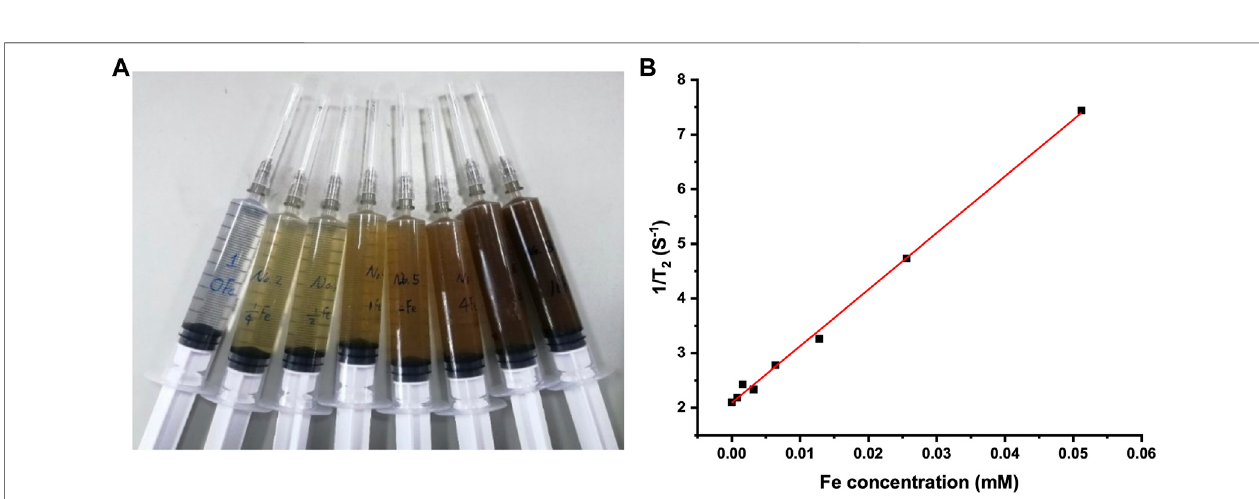
FIGURE 2 | (A) Photo of the Fe 3 O 4 @Agar/HA samples in syringes; from left to right, the fi nal Fe concentration was separately 0, 0.0008, 0.0016, 0.0032, 0.0064, 0.0128,0.0256,and0.0512 mM,theagaroseandhyaluronicacidconcentrationswereunchangedintheallsamples; (B)